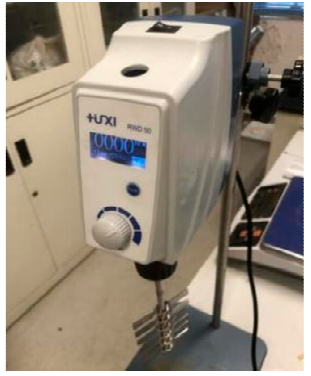
Figure 3. Blender and stirring rod.